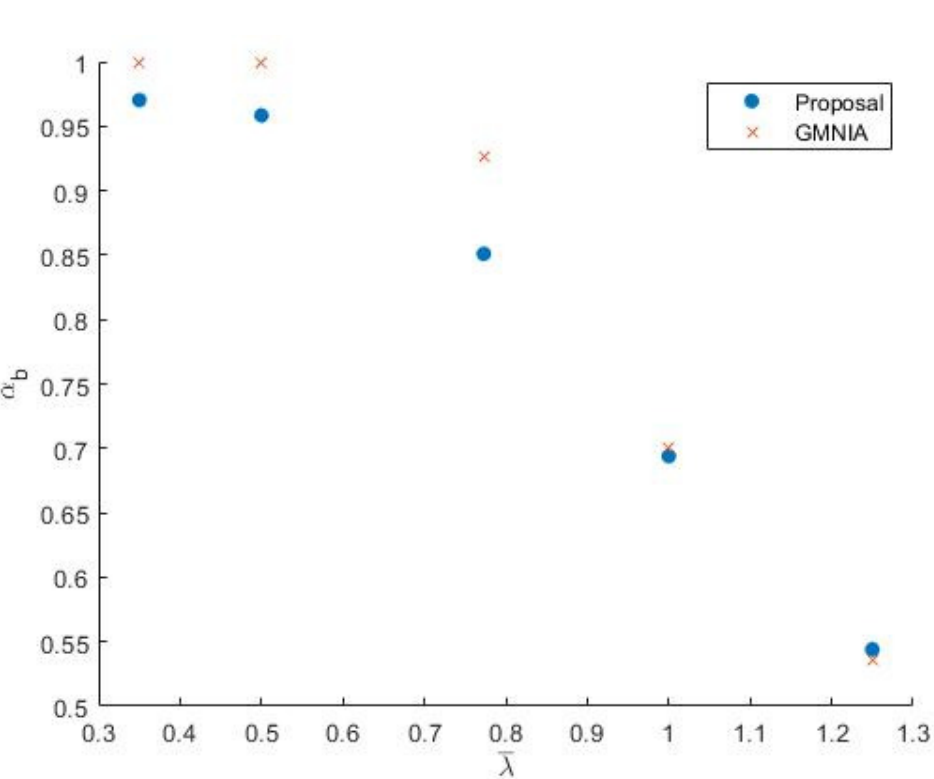
Figure 13. Example 4.2: comparison of α b values calculated for the different slenderness obtained by GMNIA and by the proposed procedure of the authors.